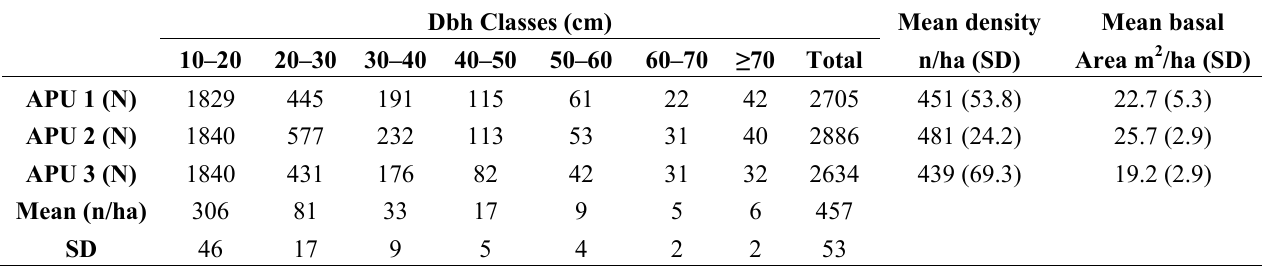
Table 4. Distribution of trees according to the dbh classes in the 18 plots of the 3